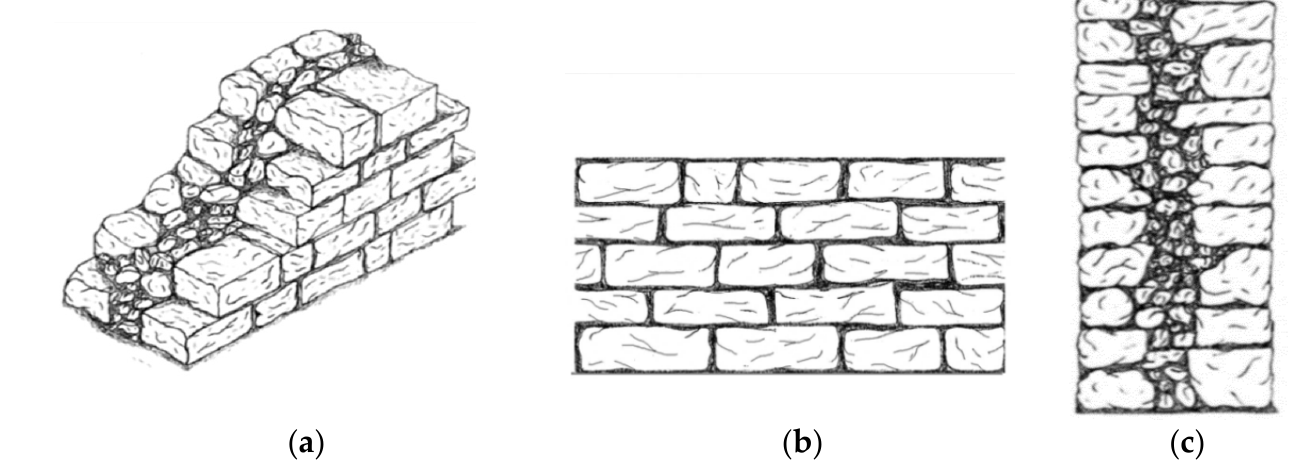
Figure 17. Sketches of a wall panel Type 2 (cross sectional thickness ≥ 60 cm): ( a ) axonometric view, ( b ) front view, ( c ) wall cross section.